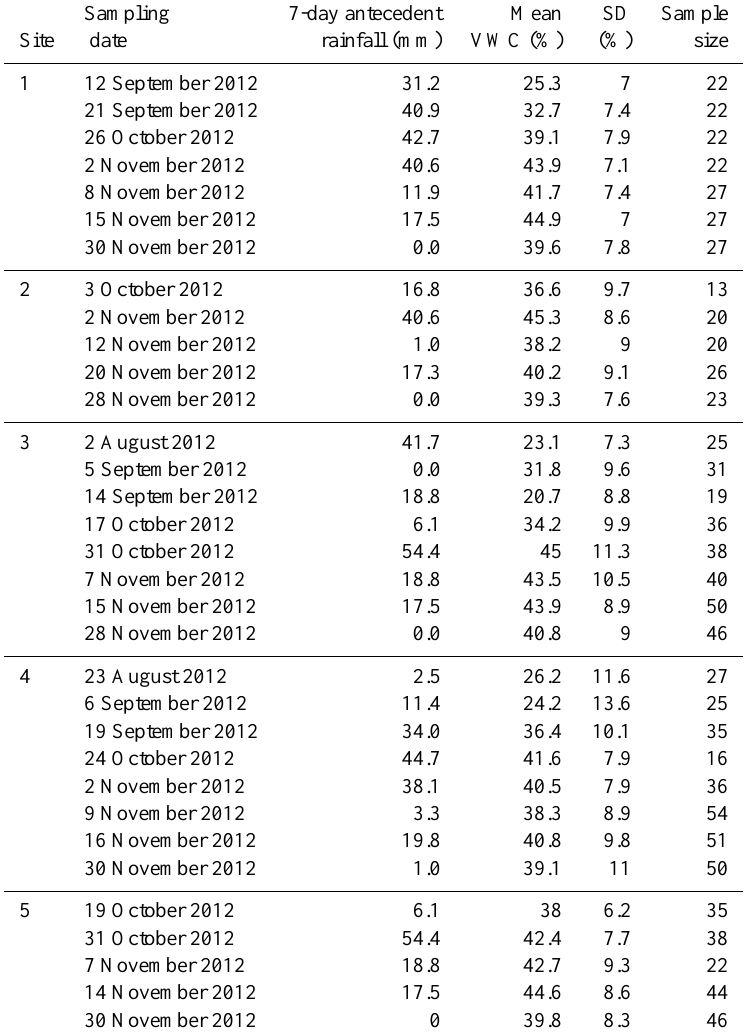
Table 2. Summary of TDR measurements at each field site. VWC represents volumetric water content. Site numbers correspond with Fig. 1. Sampling 7-day antecedent Mean SD Sample